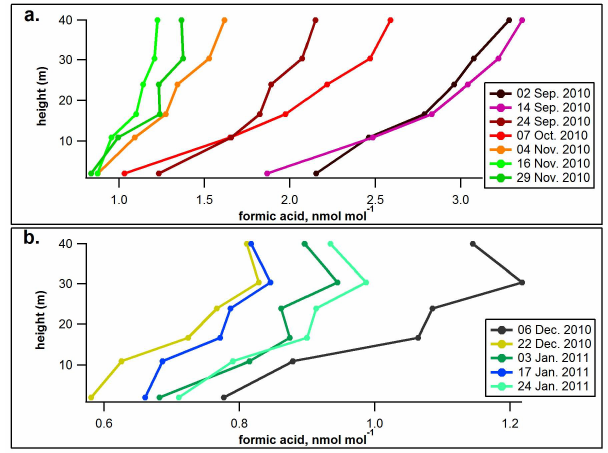
Fig. 2. Weekly averaged vertical concentrations of FA within and above the 30m canopy in the central Amazon (start date shown). (a) 2010 dry season with high FA concentrations (0.8– 3.3nmolmol − 1 ) and net deposition. (b) 2010–2011 wet season with low concentrations (0.6–1.2nmolmol − 1 ) and net emissions. The typical standard deviation at each height was about 21% of the mean FA concentration